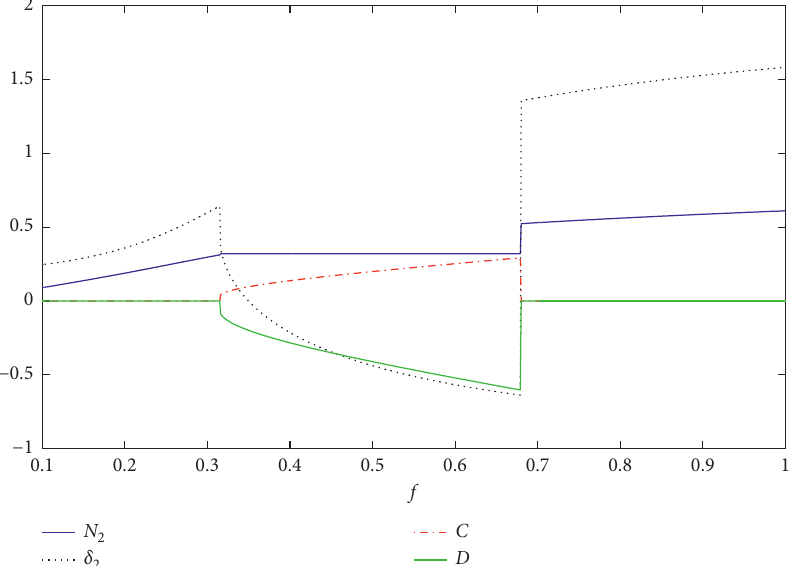
Figure 20: Comparison of NES amplitude N